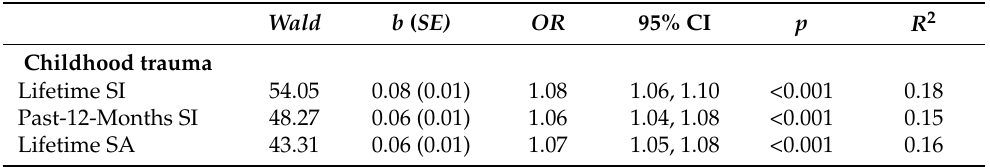
Table 4. Binary logistic-regression analysis examining childhood trauma as a predictor of suicidal